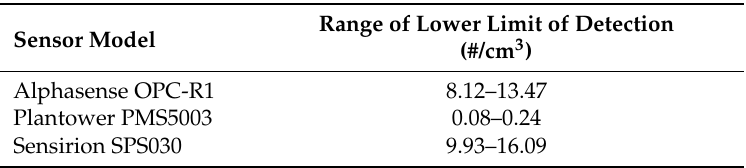
Figure 3. Lower limit of detection of the different models of sensors, under blank conditions, reported in PM 2.5 µg/m 3 . The box and whisker plot horizontal lines represent, from bottom to top, the lower quartile, the median and the upper quartile. The vertical lines are drawn to the smallest and the largest data point that fall within 1.5 times the interquartile range below the lower quartile and above the upper quartile respectively. Each dot represents the value obtained by individual sensors. Table 3. Range of the lower limit of detection of Alphasense OPC-R1, Plantower PMS5003 and Sensirion SPS030, under blank condition, reported in number of particles per